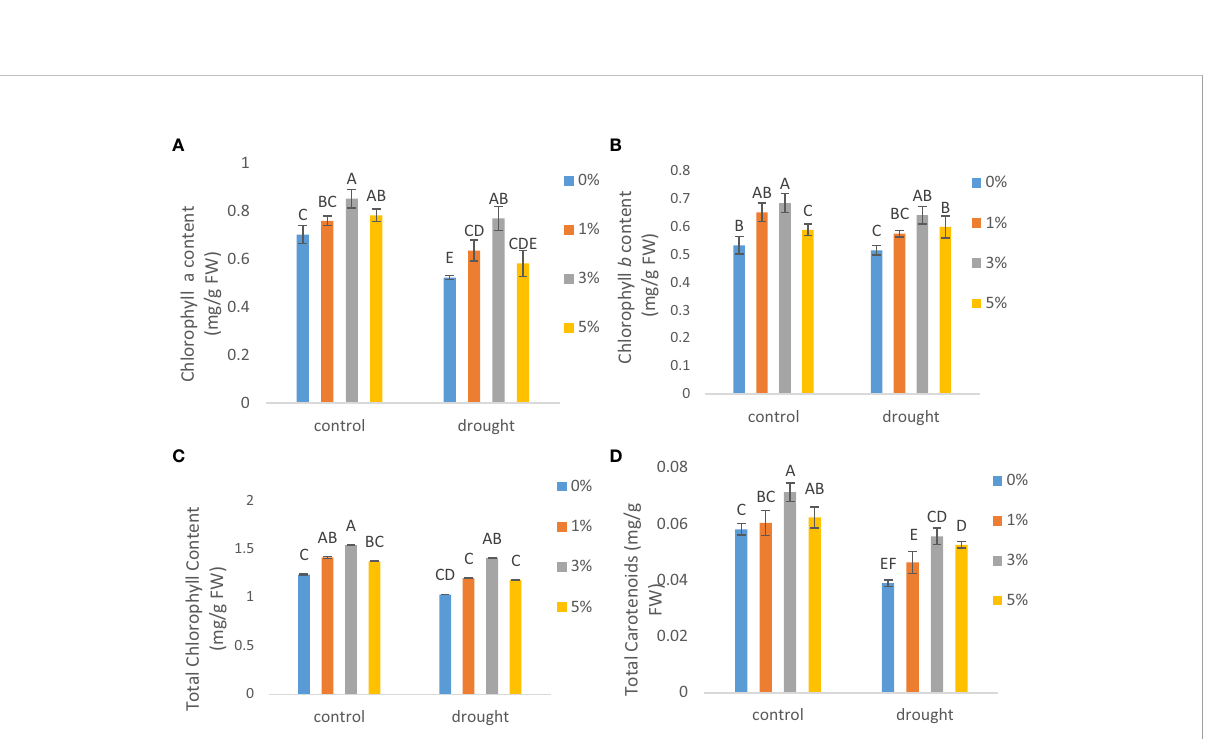
FIGURE 2 The effect of different concentrations of foliar application of nano-nutrients solution on (A) chlorophyll a , (B) chlorophyll b , (C) total chlorophyll and (D) carotenoid contents in leaves of tomato (Solanum lycopersicum) under drought. Mean values are the average of three replicates. The upper case alphabetic letters indicate signi fi cant differences (P ≤ 0.05) among treatments using Tukey's